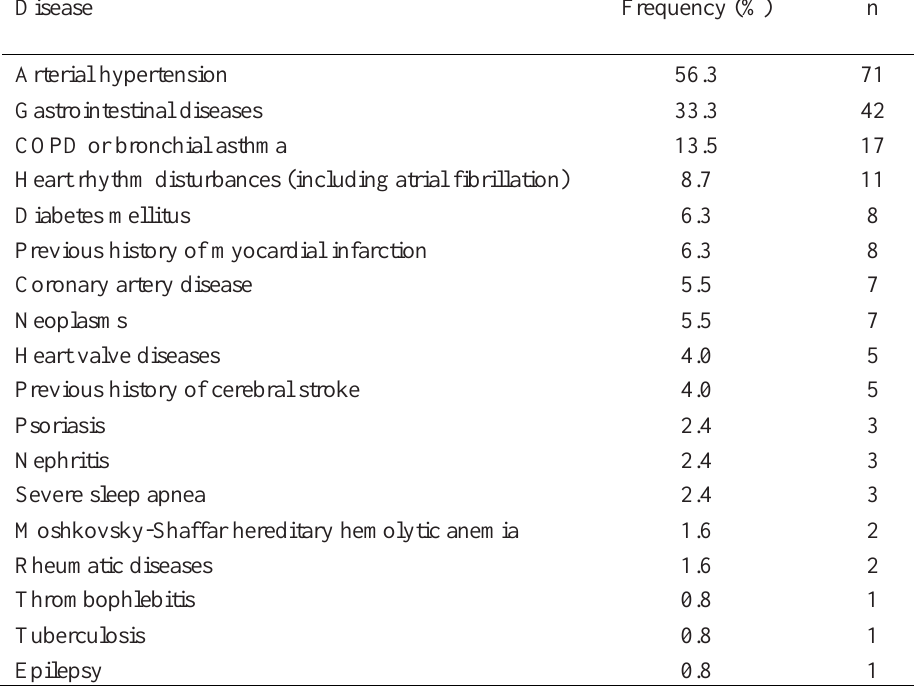
Table 2. Prevalence of self-reported non-communicable conditions National Recommendations. 7 Body